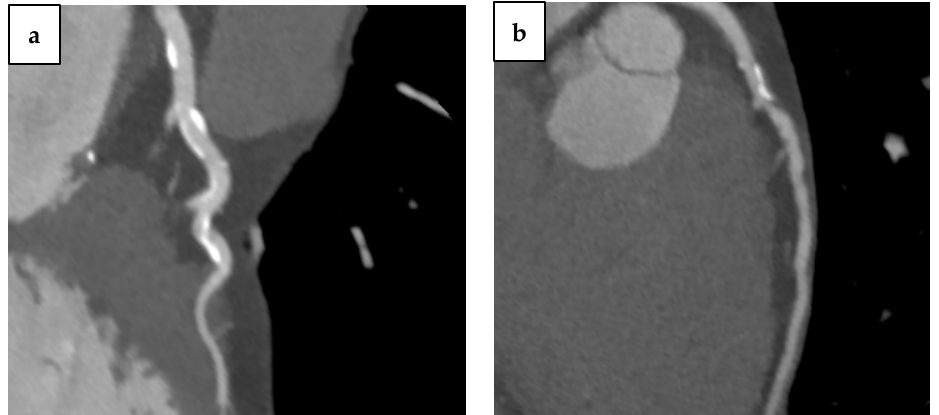
Figure 2. Coronary artery stable plaques: ( a ) calcific plaque; ( b ) fibro-calcific plaque .